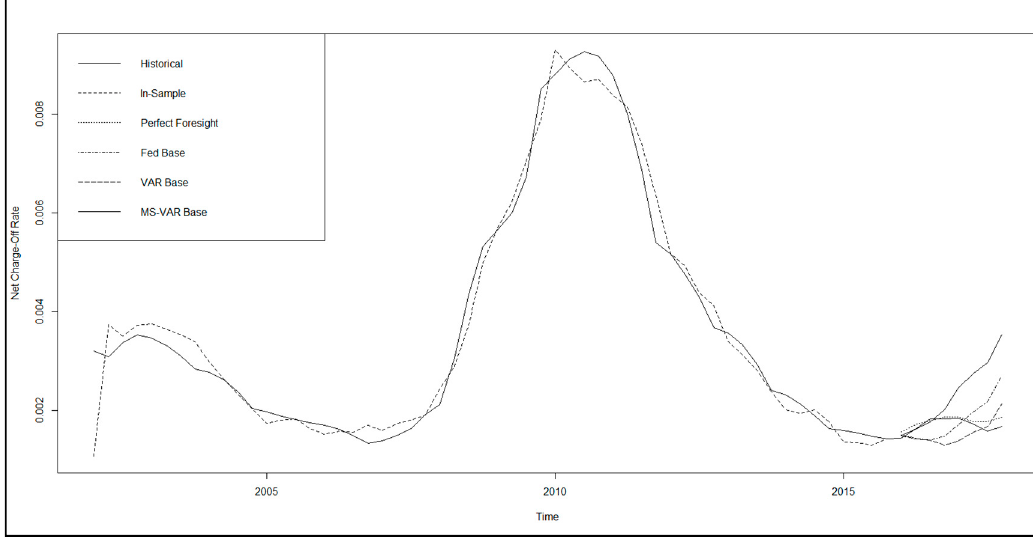
Figure 8. Net Charge-off Rate model accuracy plots—unemployment rate, commercial real estate price index, BBB corporate bond yield, and commercial development loan growth (FDIC SDI Report, Federal Reserve Board 4Q91–4Q15 and Jacobs (2018) models).